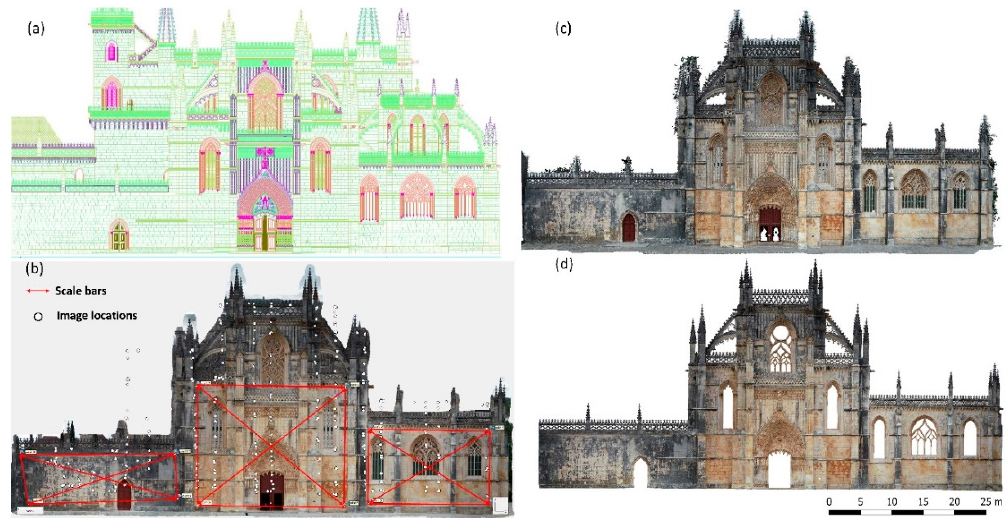
Figure 3. Generation of the orthophoto: ( a ) ancillary computer aided design (CAD) drawing used to scale the model; ( b ) location of the 18 scale bars and the 324 images acquired with a Phantom 4 Pro multirotor drone; ( c ) raw 3D point cloud generated by using an structure from motion multiview stereo (SfM-MVS) processing workflow on Photoscan Pro; ( d ) edited orthophoto with a GSD (ground sample distance) of 3.3 mm by using a textured model created from ( c ).